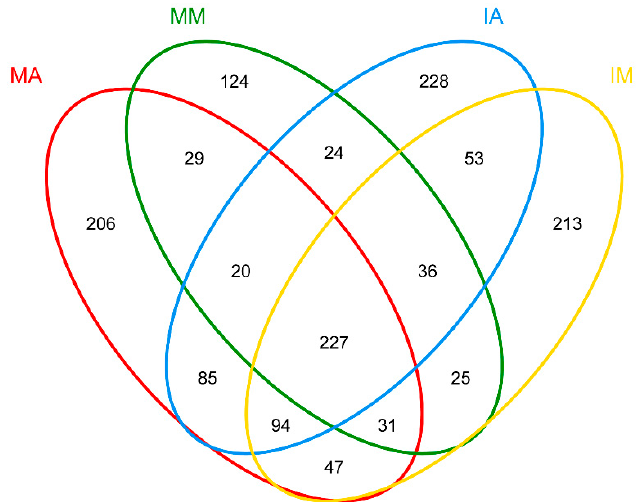
Figure 4. Venn diagram showing the shared and unique observed fungal OTUs at 97% similarity among treatments. The unique OTUs demonstrated that a different treatment had its own fungal